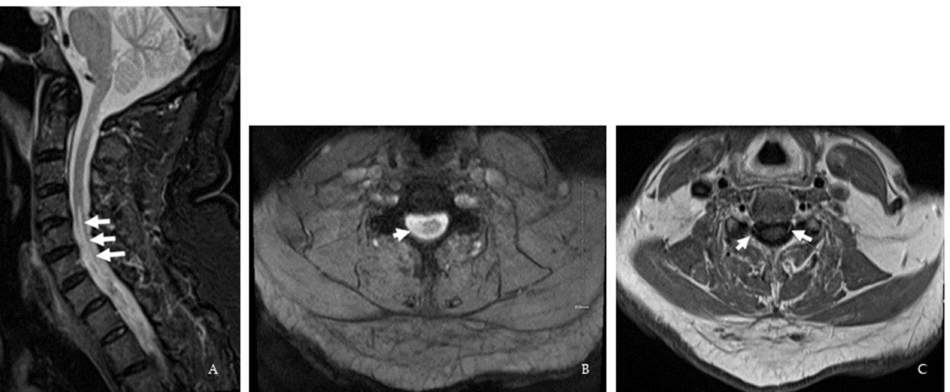
Figure 4. Case V. ( A ) Sagittal STIR cervical spine MRI shows a longitudinally extensive (5 segments) T2 hyperintensity (white arrows). ( B ) Axial cut at the specified level shows the involvement of the lateral aspect of the cervical spinal cord (white arrow). ( C ) Axial T1 post-gadolinium at the cervical level shows bilateral nerve root enhancement (white